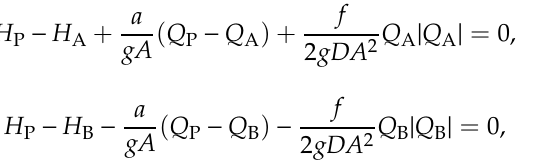
Figure 2. Parameters in the profile of a pipeline.